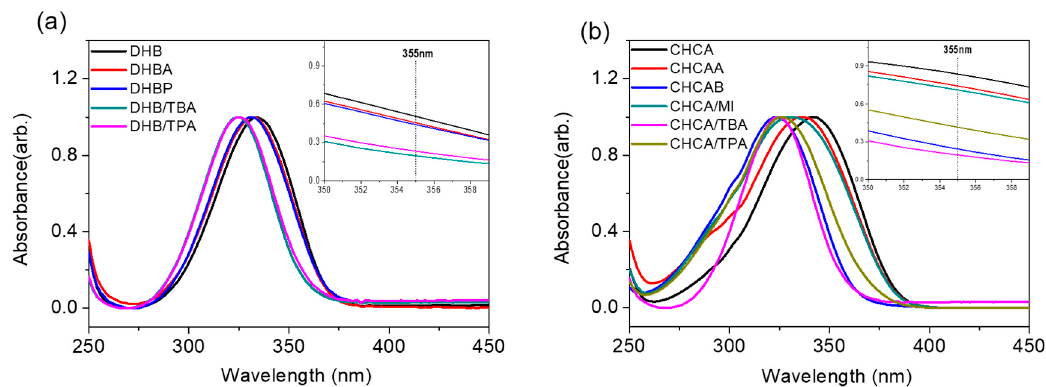
Figure 3. UV absorption spectrum of various matrices: ( a ) DHB and DHB ILs and ( b ) CHCA and CHCA ILs. All of the spectra were normalized by the highest absorption band.